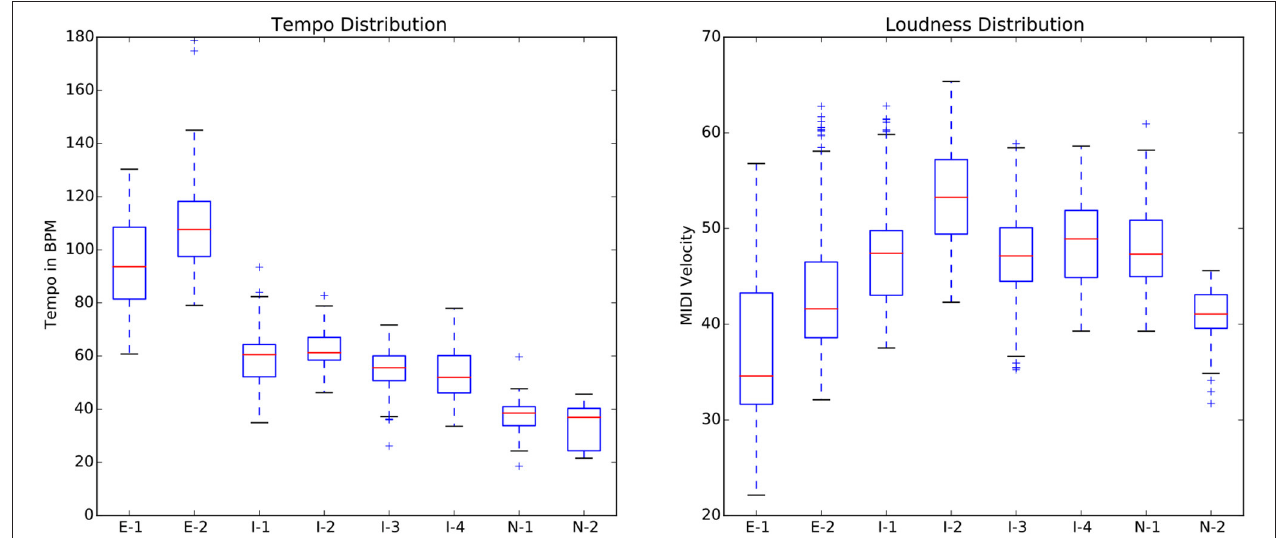
TABLE 1 | Summary statistics for expressive parameters.